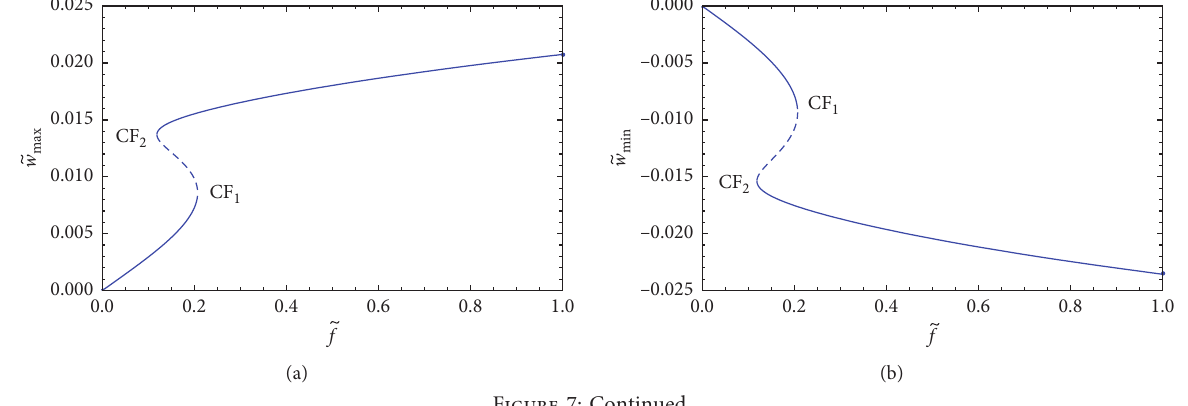
m x and z on frequency-response curves of transverse vibration of SS BDFG porous beam � 1 and varying m z